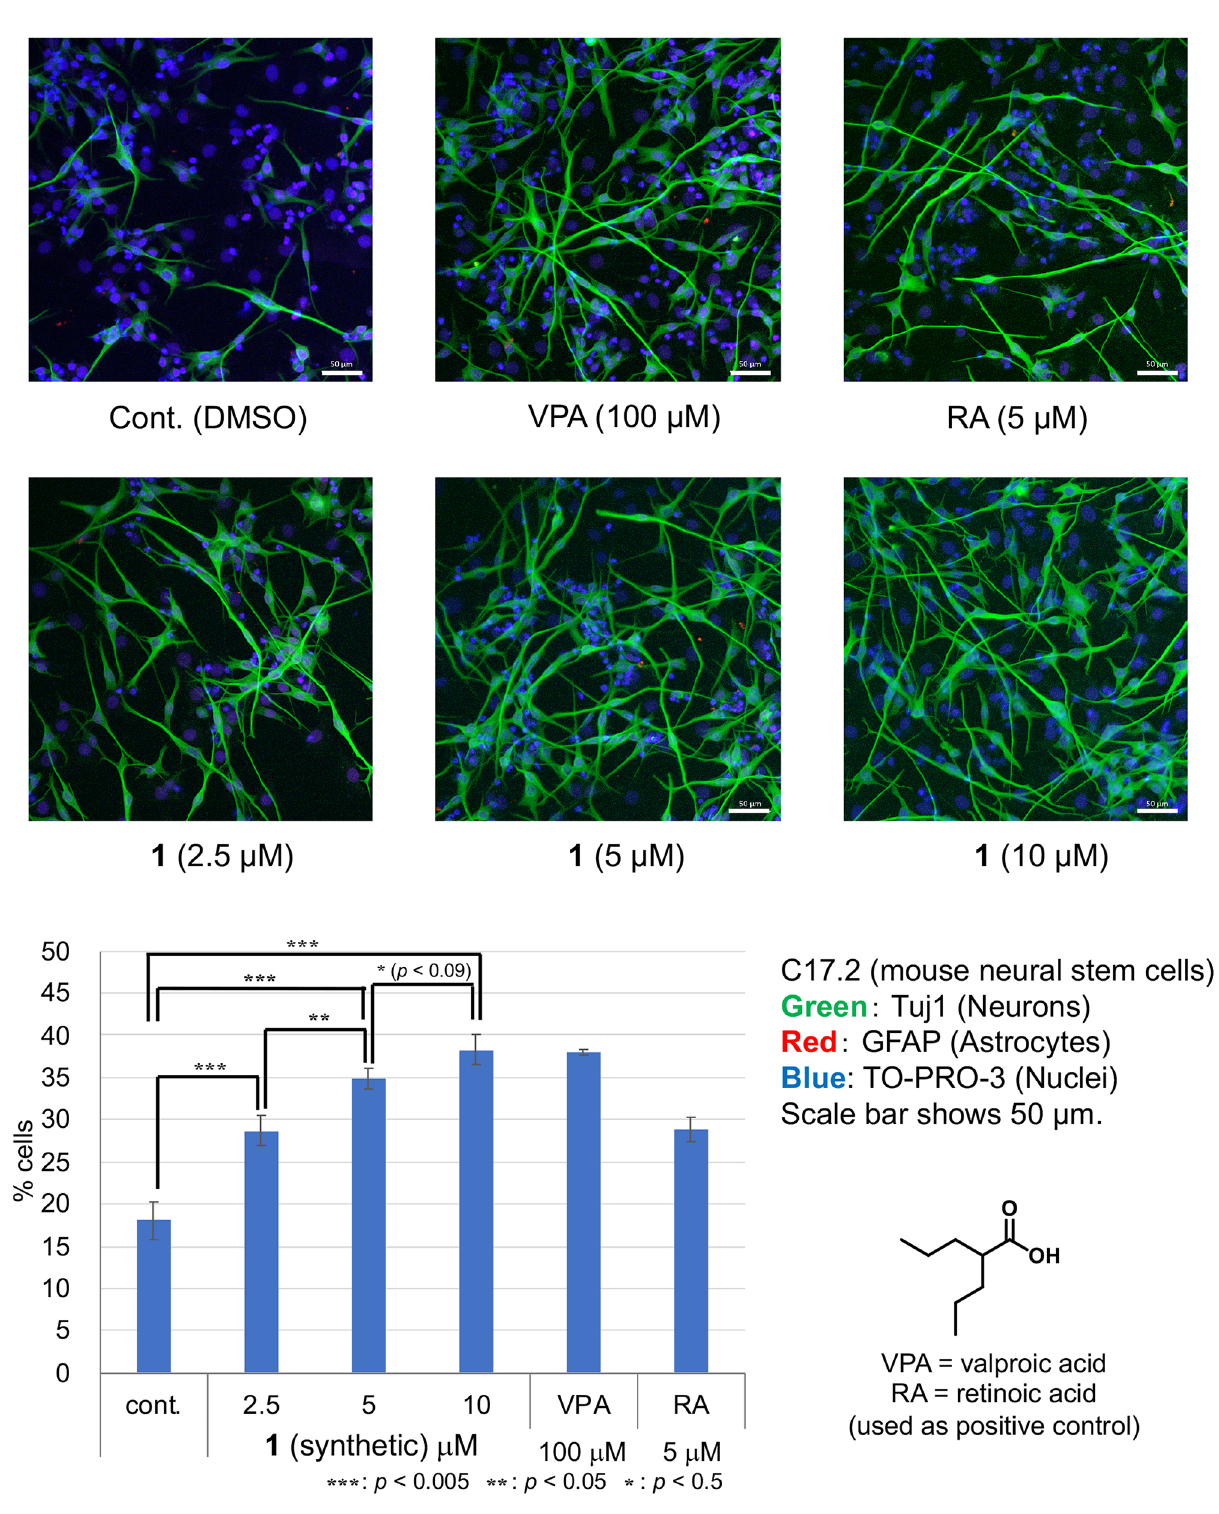
Figure 7. Effect of 1 (synthetic) on NSC differentiation into neurons after 4 days. Mouse C17.2 NSCs were used. Green: neurons; blue: nuclei; red: astrocytes. The number of neurons increased dose dependently following the addition of compound 1 . p values were determined using the Student’s t